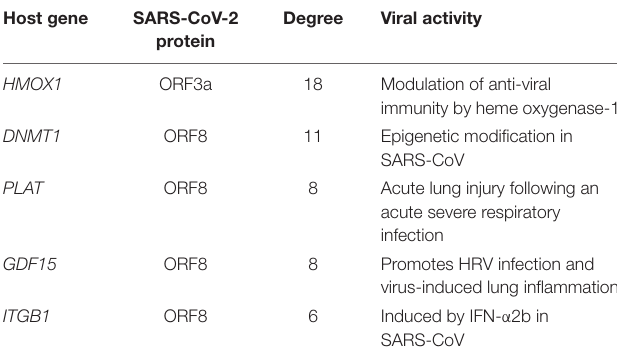
TABLE 1 | Hub genes identified from gene regulatory network